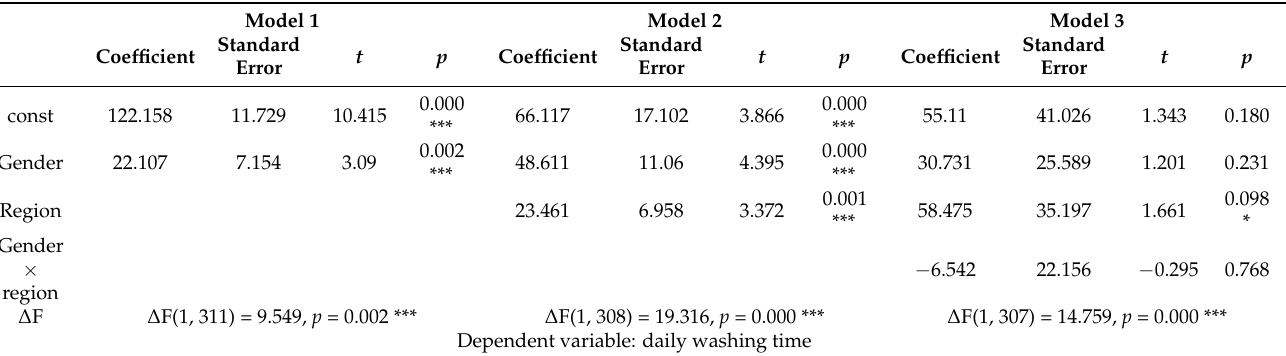
Table 4. Regulating effect analysis of the factors in the daily washing time.